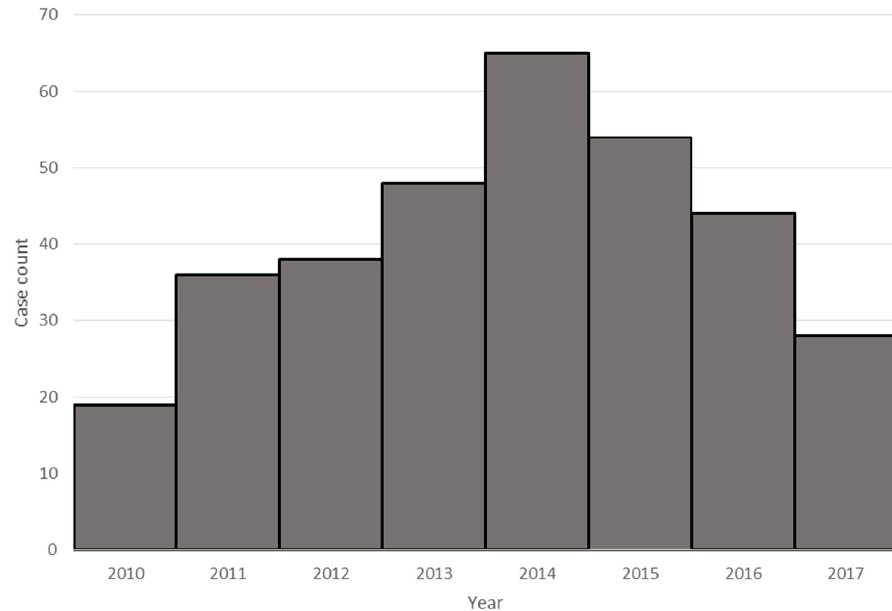
Figure 1. Selection flowchart.